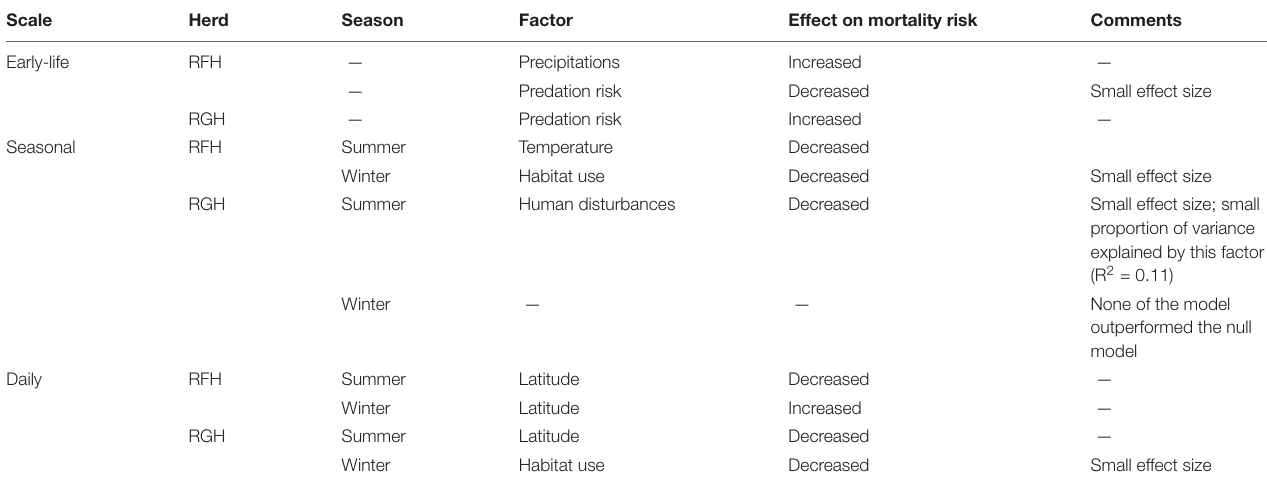
TABLE 4 | Summary of the effects of the most important factors affecting early-life, seasonal and daily mortality risk of migratory caribou of the Rivière-aux-Feuilles (RFH) and Rivière-George herds (RGH), northern Québec and Labrador, Canada, 2009 − 2016. Scale